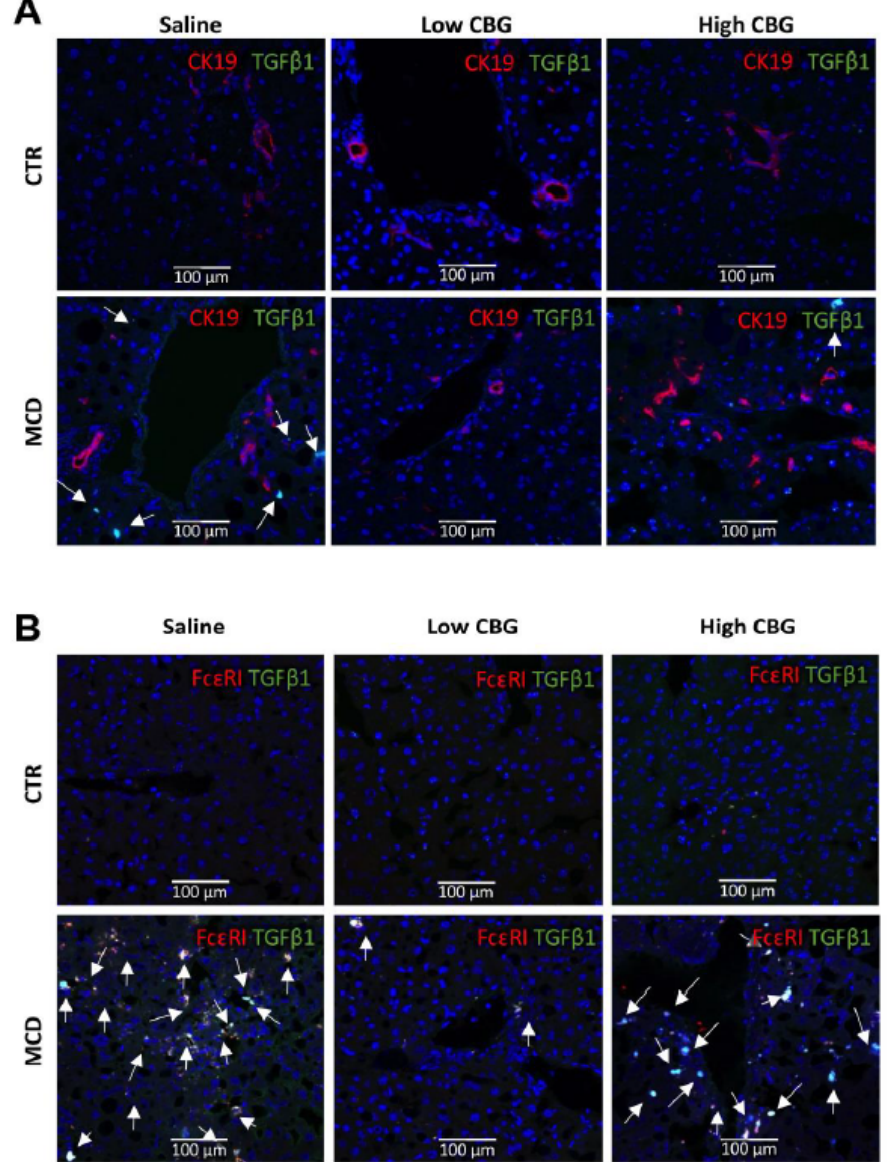
Figure 6. Colocalization of the proinflammatory marker TGF- β 1 with the cholangiocytes (CK19 + ) or mast cells (Fc ε R1 + ) in mice liver tissue. ( A ) Immunofluorescence co-staining of cholangiocytes biomarker CK19 (red) and proinflammatory factor TGF- β 1 (green), and DAPI (nuclei stained in blue). CK19 + cells were not co-localized with TGF- β 1 (white arrows). ( B ) immunofluorescence co-staining of mast cell biomarker Fc ε R1 (red) and proinflammatory factor TGF- β 1 (green), and nuclei (blue). Strong colocalization of TGF- β 1 with mast cells in MCD groups (white arrows). Pictures are taken at 20× magnification.